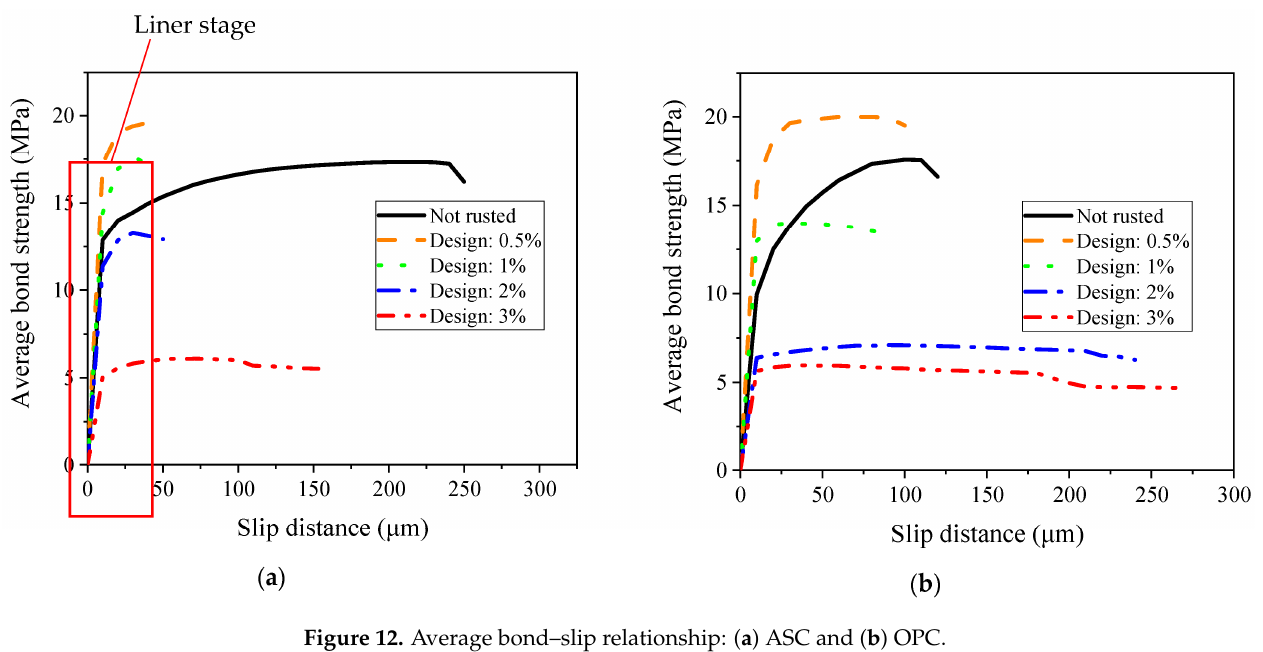
Figure 12. Average bond–slip relationship: ( a ) ASC and ( b ) OPC .